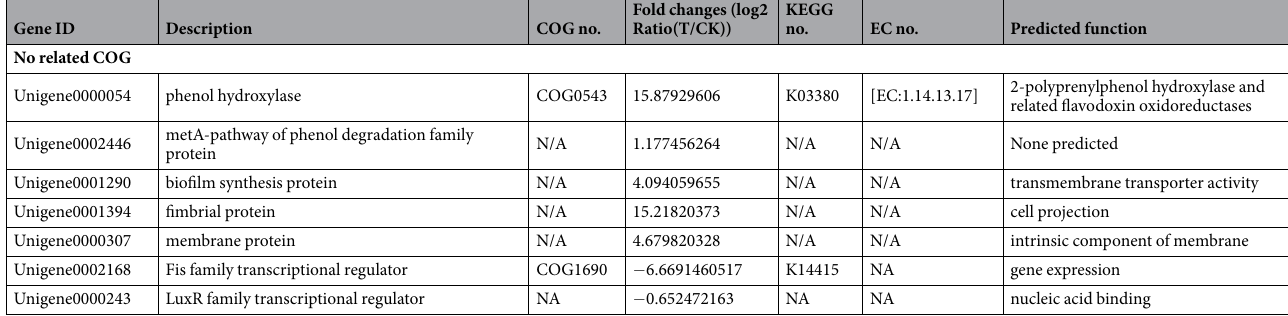
Table 4. Functions of key genes detected by RNA-Seq. N/A: Not